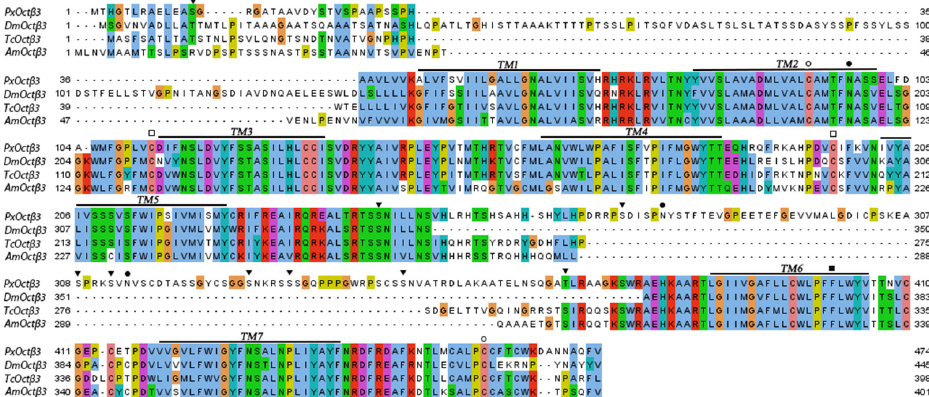
Figure 1. Amino acid sequence alignment of PxOct β 3 and orthologous receptors from Apis mellifera (XP_006557730.1), Drosophila melanogaster (NP_001034043.2), and Tribolium castaneum (NP_001280505.1). The seven predicted transmembrane regions are denoted by TM1to M7. Potential N-glycosylation and phosphorylation sites by PKC are marked with filled circles and triangles, respectively. Potential palmitoylation sites are marked with empty circles. Two conserved cysteine residues are marked with empty squares. The second phenylalanine after the FxxxWxP motif in TM6, a unique feature of aminergic GPCRs, is marked with a filled square. GPCR, G-protein-coupled receptors; PKC, protein kinase C.